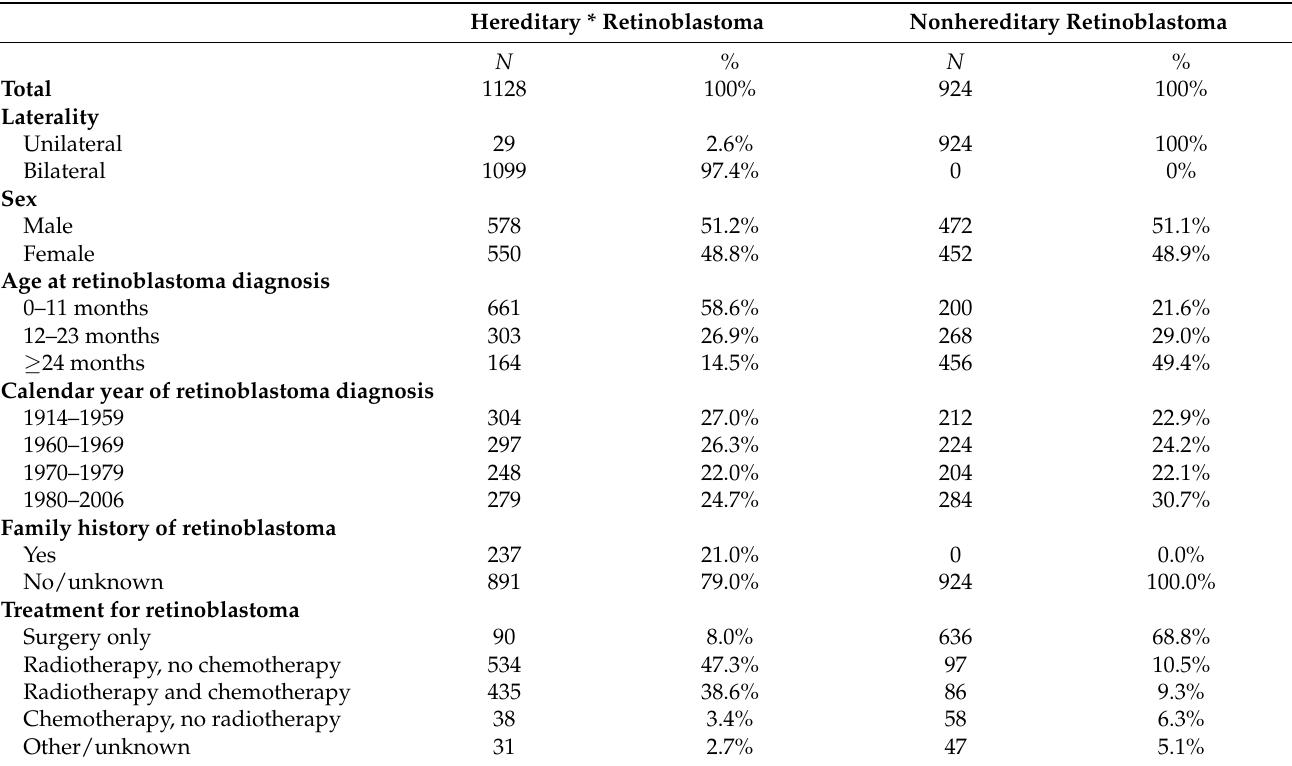
Table 1. Characteristics of 2052 retinoblastoma